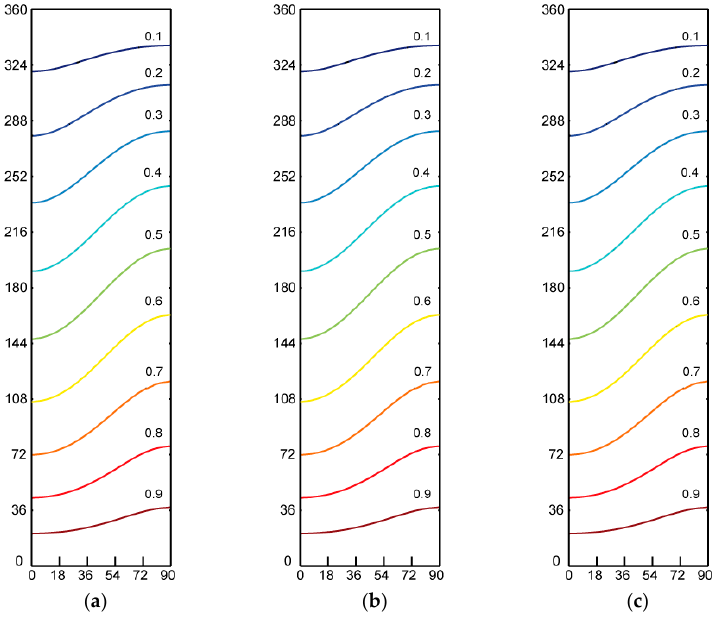
Figure 3. Steady state temperature pattern for the first application (Ra = 200): ( a ) Case 1; ( b ) Case 2; and ( c ) Case 3.